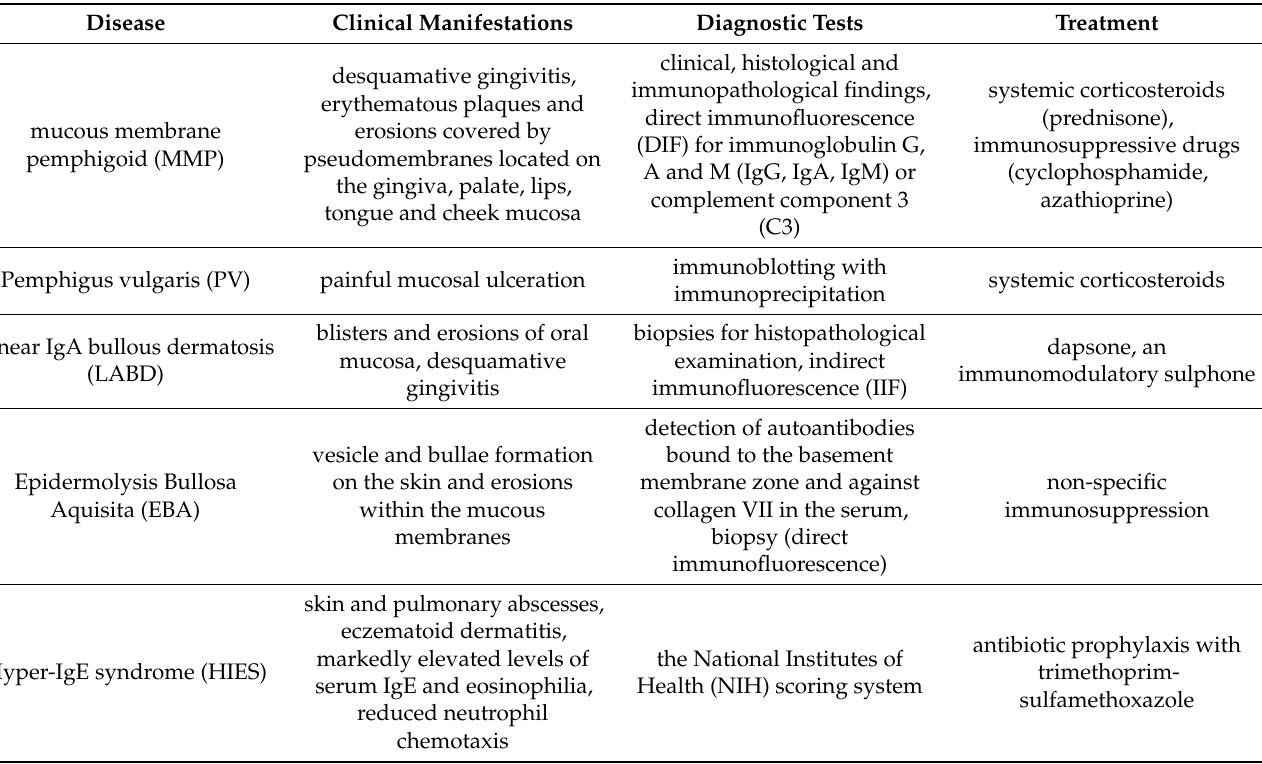
Table 1. Characteristics of selected diseases manifested in the oral